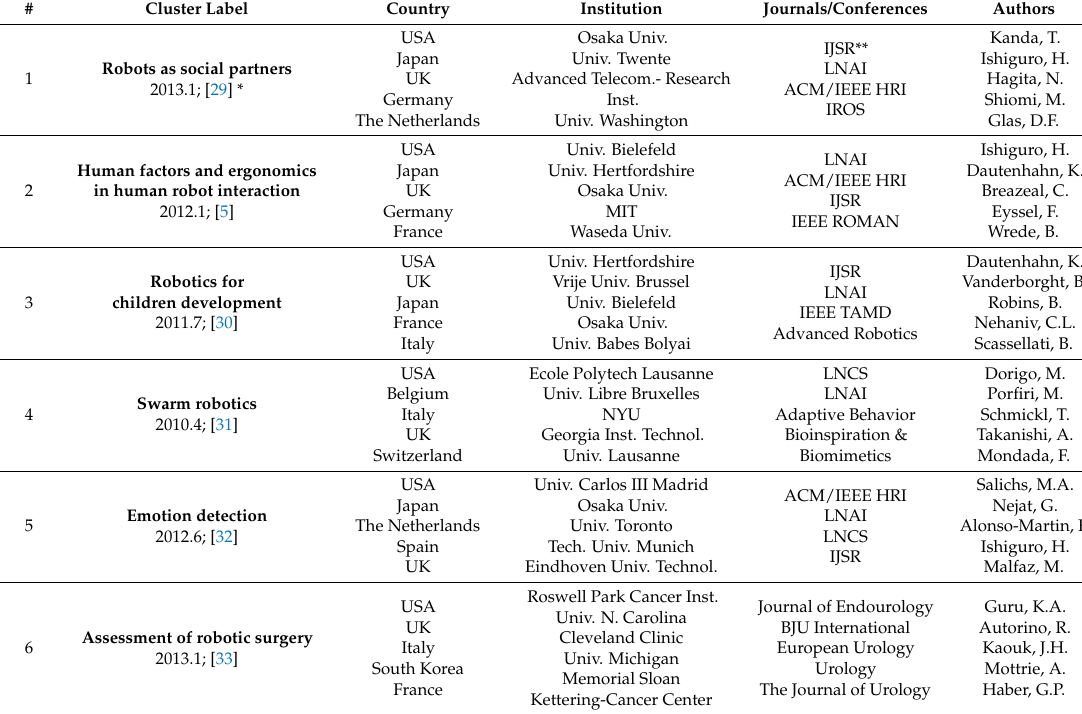
Table 3. Bibliometric taxonomy of social robotics. Most frequent countries, institutions, publishers and authors are